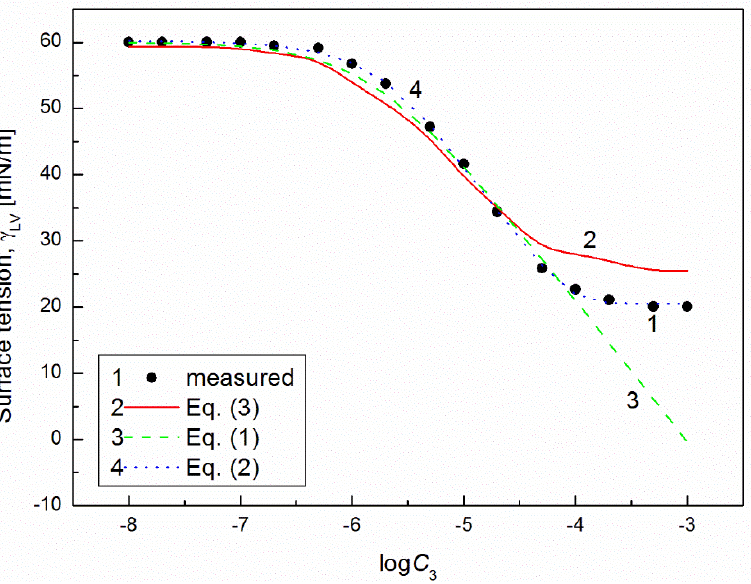
Figure 3. A plot of the surface tension ( γ LV ) of the aqueous solutions of CTAB + TX100 + FC2 mixture at the constant concentration of the binary mixture CTAB + TX100 ( C 12 ) and γ LV = 60 mN/m (m2 (60)) vs. the logarithm of FC2 concentration ( logC 3 ). Points 1 correspond to the measured values, curves 2, 3 and 4 correspond the values calculated from the Fainerman and Miller (Equation (3)), the Szyszkowski equation (Equation (1)) and the second order exponential function (Equation (2)), respectively.